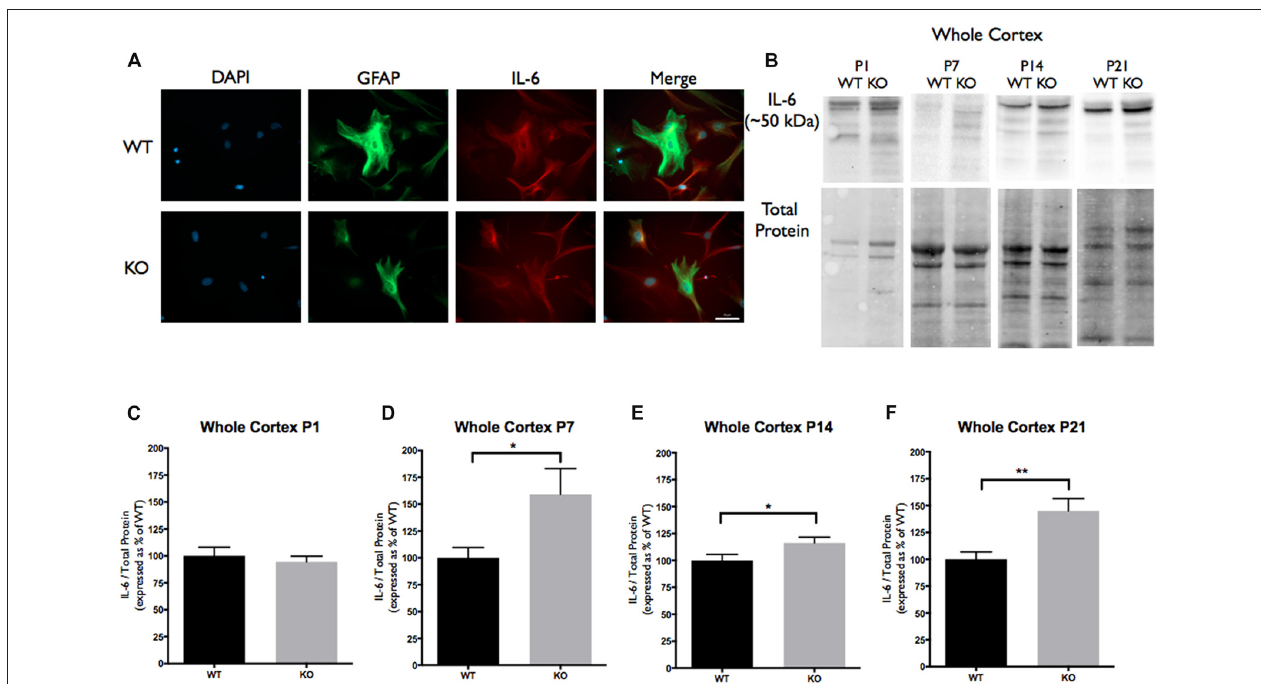
FIGURE 3 | Interleukin-6 (IL-6) expression is significantly increased at postnatal day P7, P14 and P21 in the cortex of FMR1 KO mice. (A) Cultured cortical astrocytes co-labeled with anti-GFAP (green), DAPI (blue) and anti-IL-6 (red) after 3 days in vitro . Images were obtained using a 40 × objective with a Zeiss Axioimager M2. Scale bars = 50 µ m. (B) Western blots showing IL-6 expression ( ∼ 50 kDa) in cortical samples containing 30 µ g of protein from P1, P7, P14 and P21 WT and FMR1 KO mice. Corresponding total protein was used as a loading control. (C–F) Cortical expression of IL-6 in WT (black; n = 8) and FMR1 KO (gray; n = 8) mice at P1 (six males and two females), P7 (five males and three females), P14 (six males and two females) and P21 (eight males and zero female). Representative bands were normalized to the total protein and expressed as a percentage of the average IL-6 in the WT group. Statistical differences denoted with a single asterisk, P < 0.05 and with a double asterisk, P <